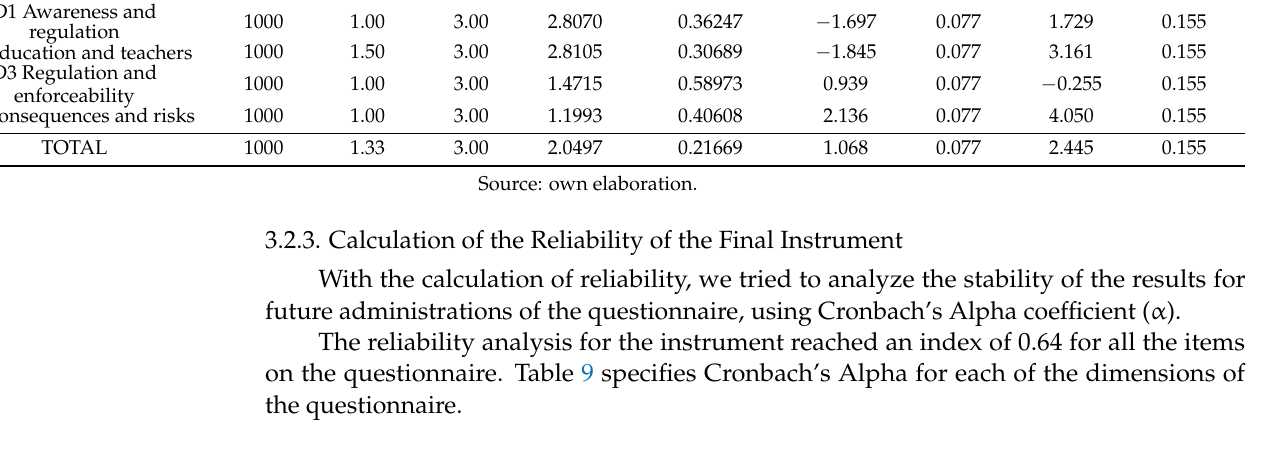
Table 9. Cronbach Alpha by dimension and its